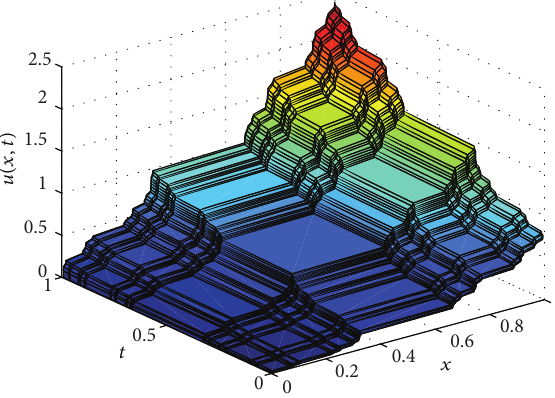
Figure 1: The plot of 𝑢(𝑥,𝑡) for the parameter 𝛼 = ln 2/ ln 3